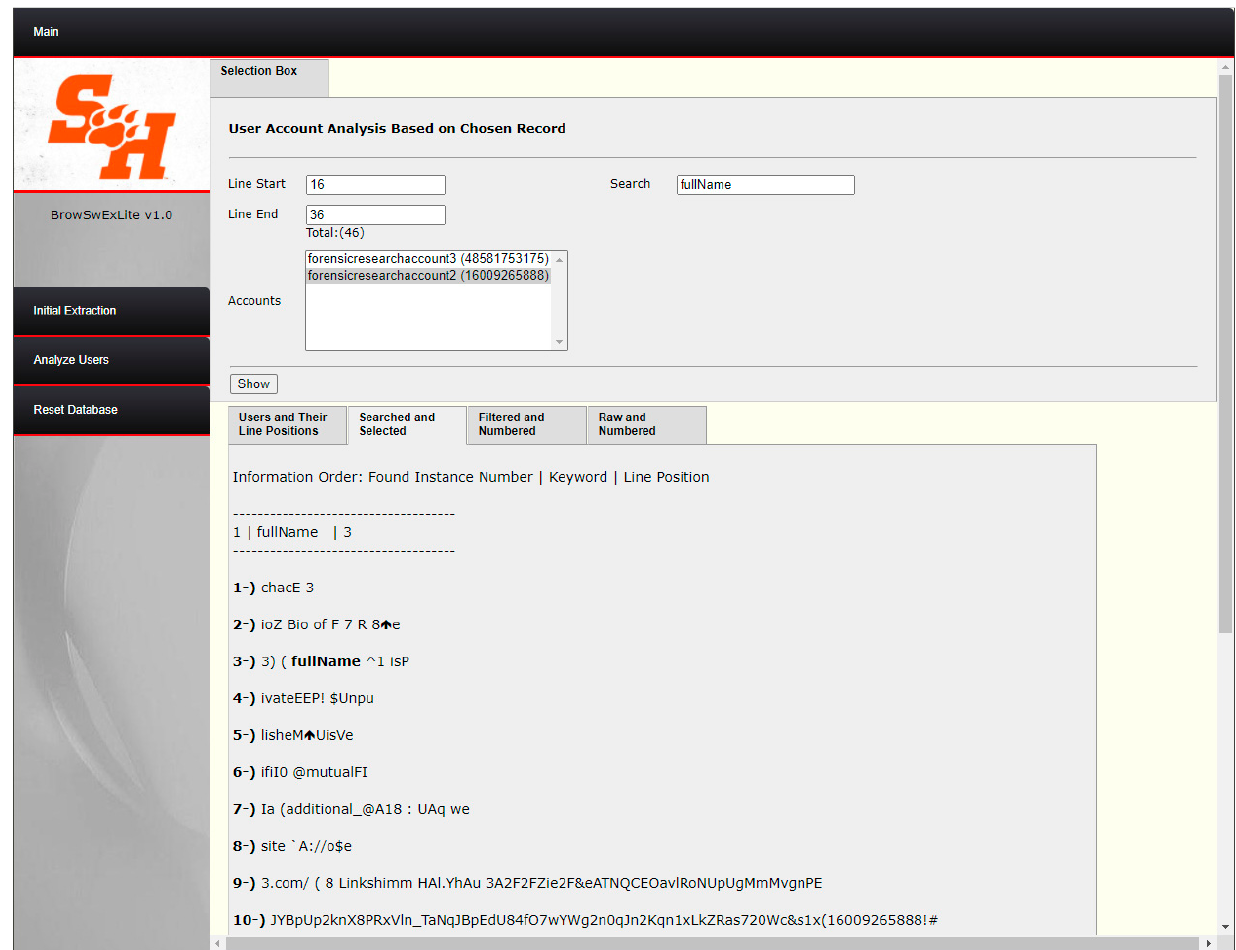
Figure 5. Searching Records in Processed and Raw Format.